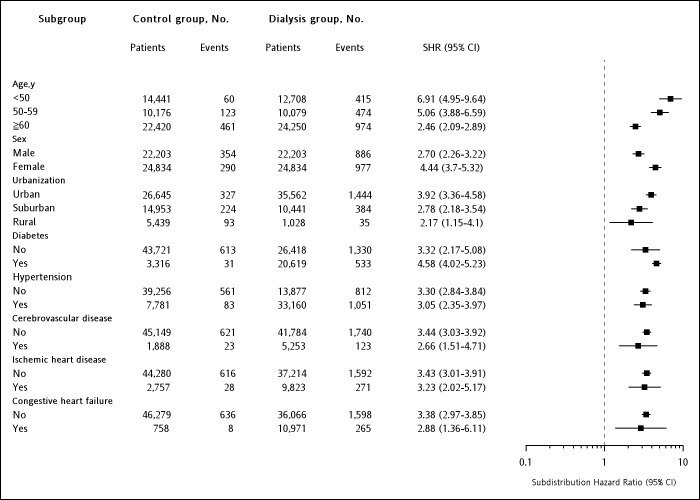
Multivariable stratified analyses for the association between dialysis and cancer.Abbreviation: SHR, subdistribution hazard ratio; CI, confident interval.